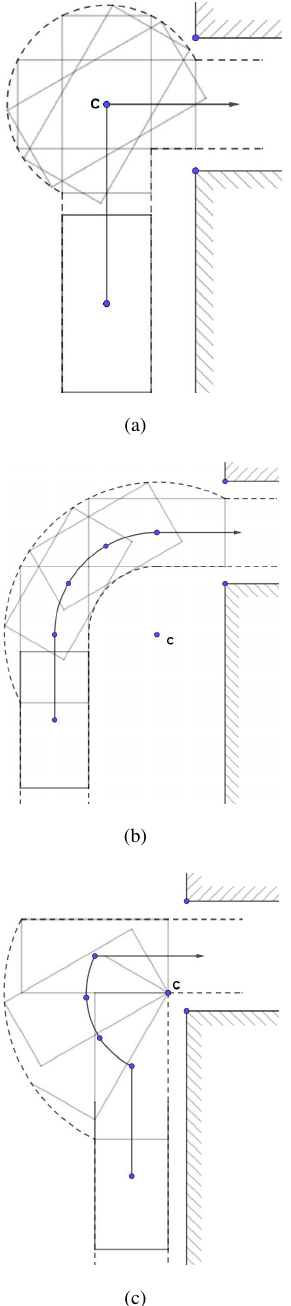
Figure 13. The trajectories of RRB with different rotation centres. All the rotation centres are C